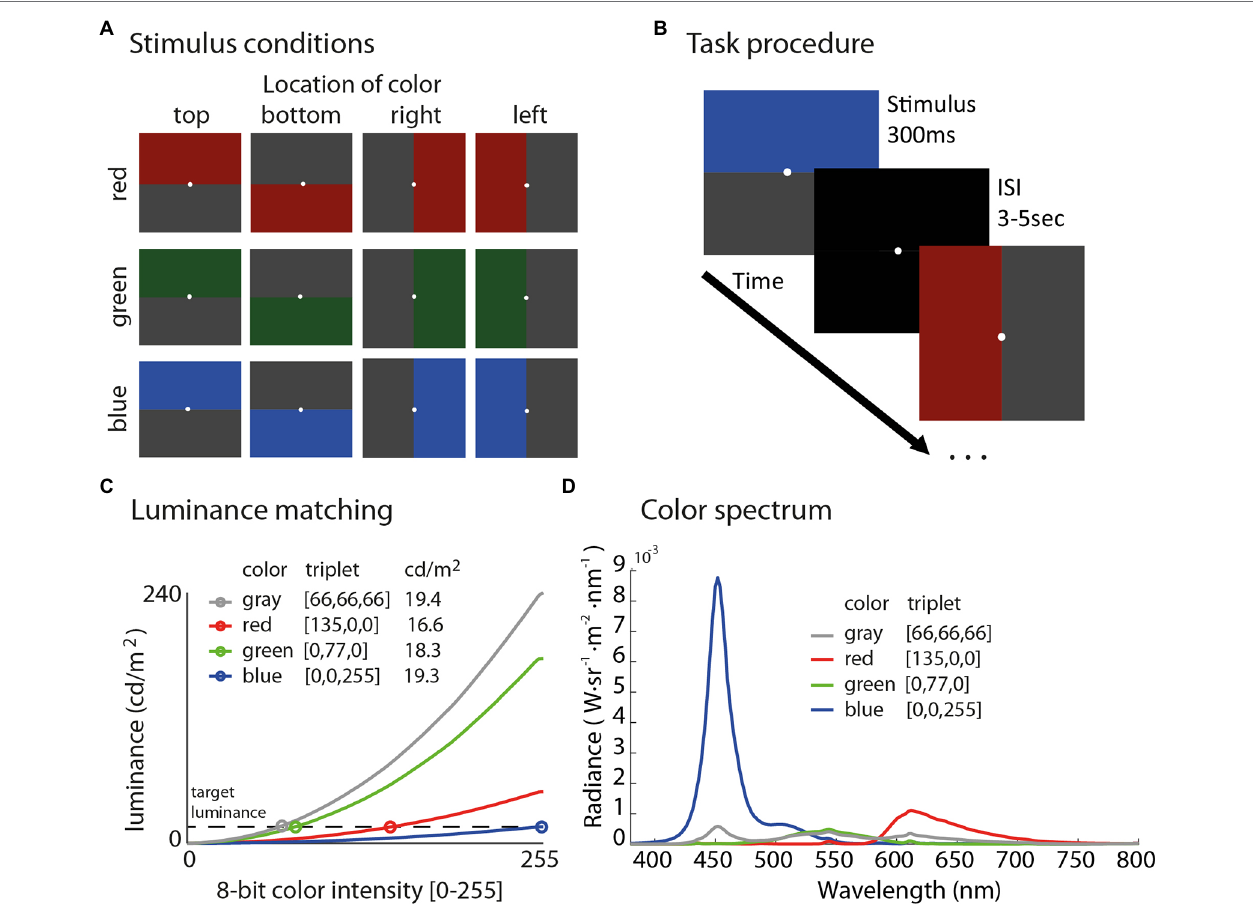
FIGURE 6 | Illustration of all 12 stimuli in the experiment (A) sorted by color in rows and location in columns. Schematic of the task procedure (B) shows that subjects fixated on a white dot and were presented each stimulus for 300 ms followed by an inter-stimulus interval (ISI) with a black screen for 3–5 s. Stimuli were luminance matched using measurements from a spectroradiometer (C) to evaluate the specific influence of color and location on the PLR, while controlling for overall luminance between conditions, which ranged from 16.6 to 19.4 cd/m 2 . The color spectrum plot (D) shows radiance as a function of wavelength derived from the spectroradiometer for each color